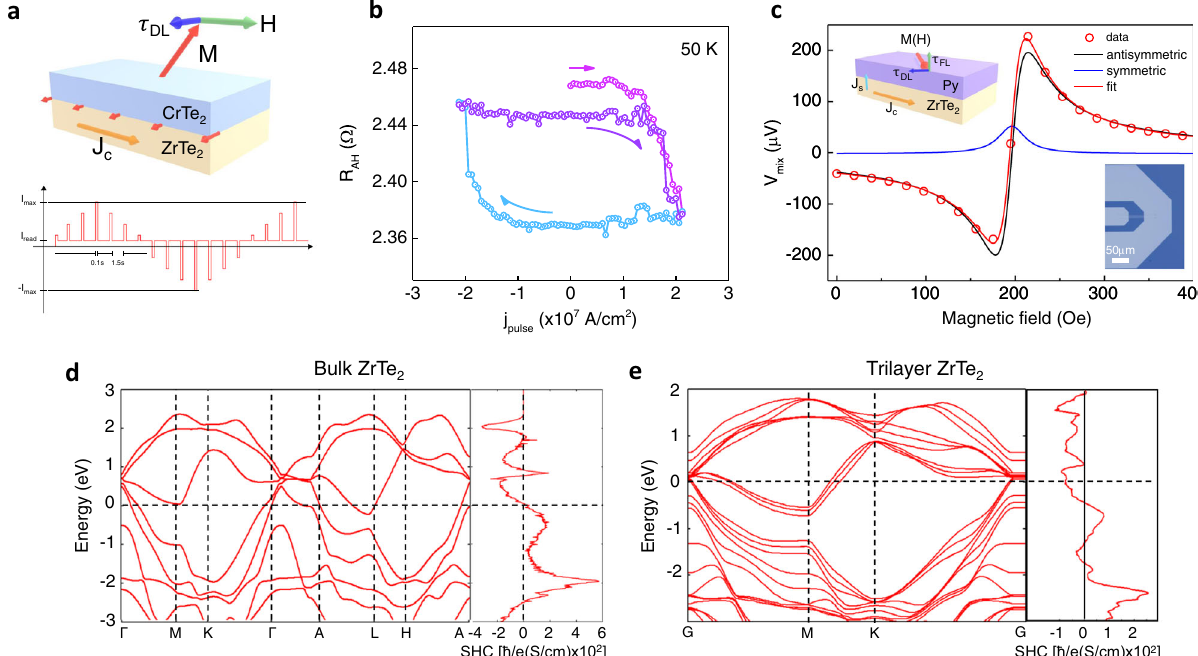
Fig. 4 Pulsed current-induced magnetization switching of an ultrathin ZrTe 2 /CrTe 2 heterostructure device and SOT characterizations of ZrTe 2 . a Schematics of the SOT assisted magnetization switching in the ZrTe 2 /CrTe 2 heterostructure and the writing and reading pulse current sequence. b Pulse current-induced magnetization switching of a ZrTe 2 (8 u.c.)/CrTe 2 (3 u.c.) at 50 K under an external magnetic fi eld (700 Oe) applied in-plane parallel to the current direction. c ST-FMR spectrum of a ZrTe 2 /Py bilayer heterostructure at room temperature. Inset: Optical microscope image and schematic of the ST-FMR device. d , e DFT calculated band structure and spin Hall conductivity of ZrTe 2 in the bulk and thin fi lm form,